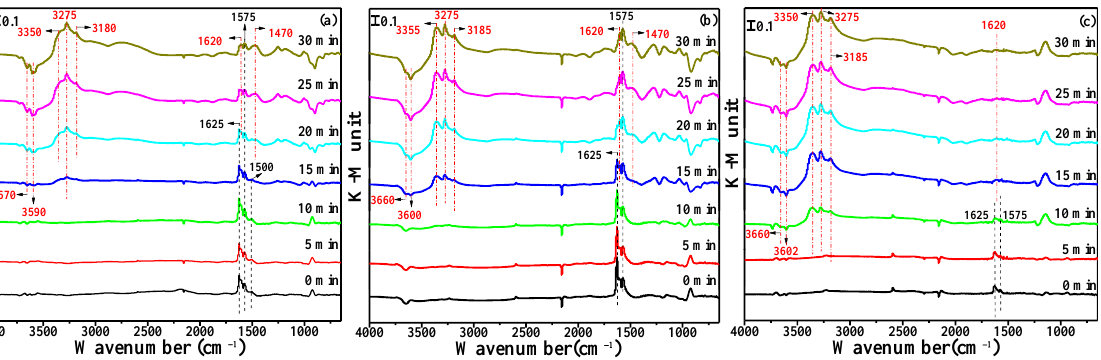
Figure 12. In situ DRIFT spectra of NH 3 reacted with pre-adsorbed NO + O 2 on the copper-based zeolites at 150 ◦ C for 30 min: ( a ) Cu-SSZ-13; ( b ) Cu-ZSM-5 and ( c )